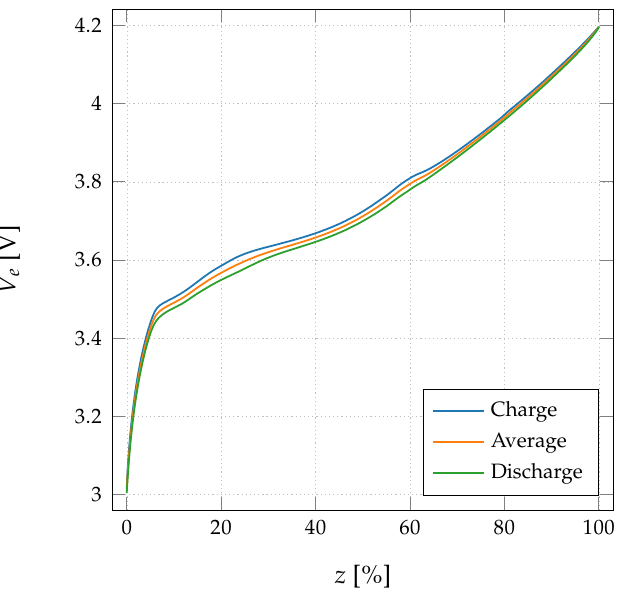
Figure 4. Top: identified SoC-V e relation from I (cid:101) current. Bottom: difference of the other current curves from the I (cid:101) curve.